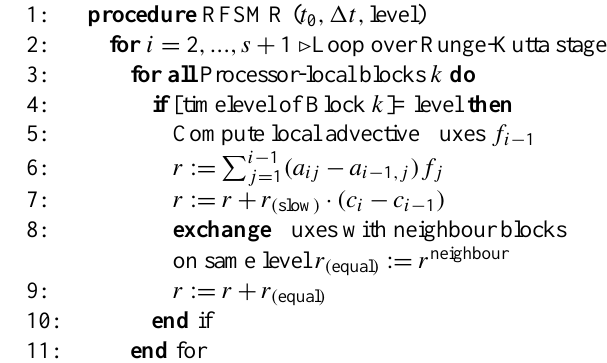
Fig. 2. Geometrical cell structure of adjacent blocks. Halo cells depicted with thinner contours. Connectors between blocks indicate multiple representations of the same physical volume.